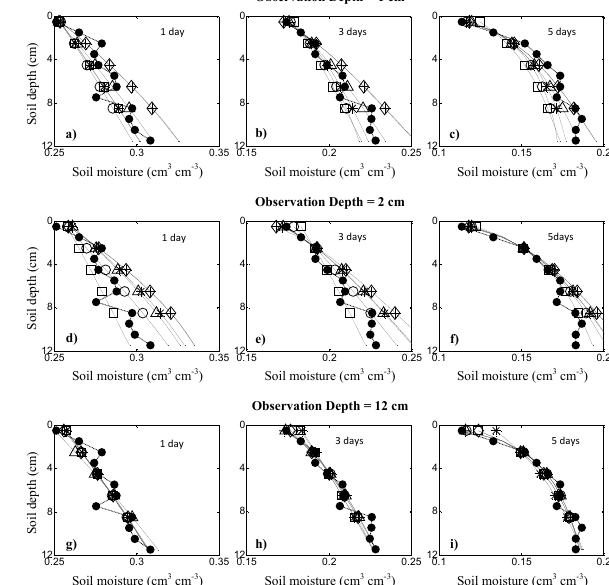
Figure 8. Retrieved soil moisture profiles (solid lines) using the GA3 data series after 1 day (a, d, g) , 4 days (b, e, h) and 7 days (c, f, i) , with assimilation frequency AF = 1/2h − 1 and observation depths: (a–c) OD = 1cm, (d–f) OD = 2cm, and (g–i) OD = 12cm. Comparisons account for the six pondered sets of initial parameters S1( (cid:13) ) , S2( (cid:3) ) , S3( ∗ ) , S4( 1) , S5( + ) and S6( ♦ ) . The dotted line with solid circles represents the measured profile.